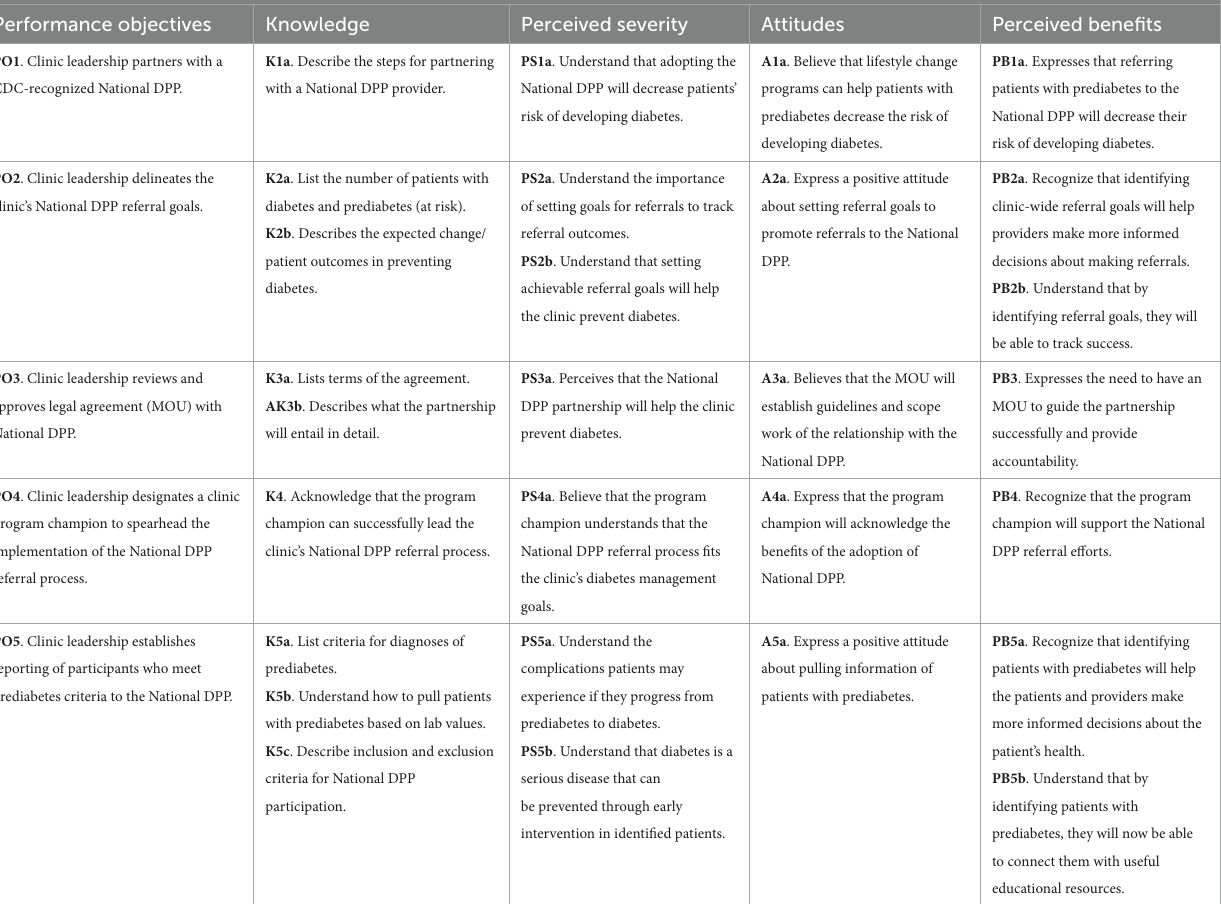
TABLE 3 Sample matrices of change objectives for the adoption of the National Diabetes Prevention Program among the participating clinics in Texas, United States. Adoption outcome: Clinic leadership adopts National DPP to prevent diabetes among patients with prediabetes. Performance objectives Knowledge Perceived severity